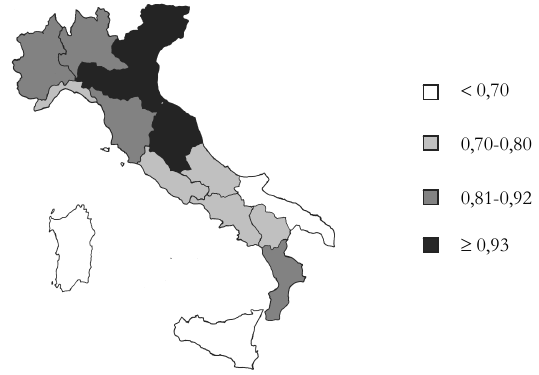
Figura 1a – Neonatal mortality in the Italian regions, 1881-1882.